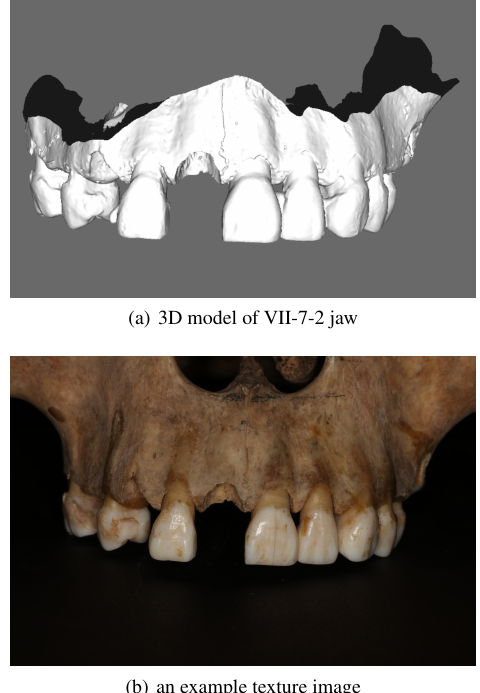
Figure 6. Jaw 3D model obtained computed tomography and texture image.